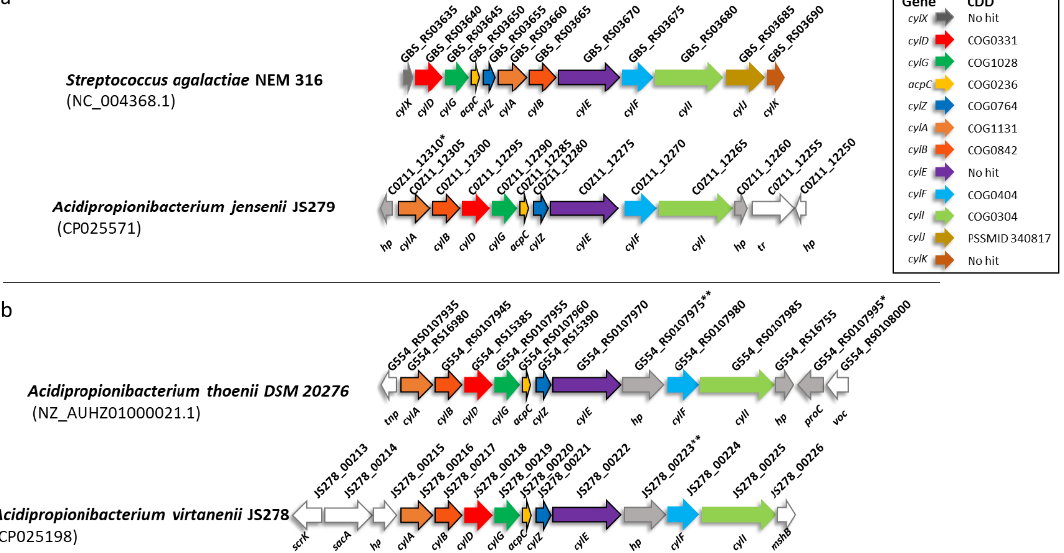
Figure 2. Genes and organization of cyl gene cluster in ( a ) Streptococcus agalactiae and A. jensenii JS279; ( b ) cyl gene cluster in other acidipropionibacteria. The genes previously shown as necessary for production of pigment and haemolytic activity in S. agalactiae ( acpC, cylZ, cylA, cylB, cylE ) are outlined in black. Homologous genes are marked with matching colours, the conserved domains in gene products are shown in the figure legend. Genes without homology to S. agalactiae cyl cluster are light grey. Genes without homology between acidipropionibacteria are additionally filled in white. * Proteins encoded by COZ11_12310 and G554_RS0107995 share 100% sequence identity over 95 aa. ** No homologue is found in the strain JS279 annotated with PGAP. In PROKKA annotation a hypothetical protein encoded by a gene located at 2750821–2752134 shares a 65% identity with JS278_00223.